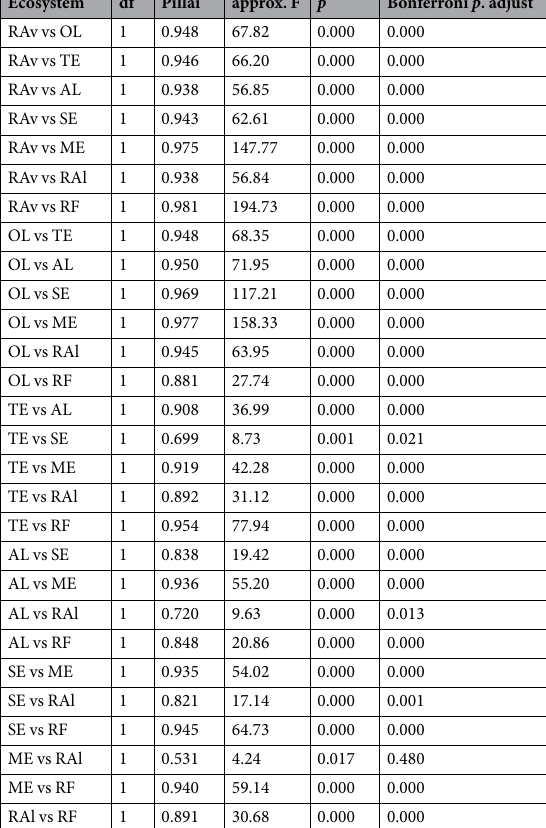
Table 1. Multivariate analysis of variance (MANOVA) of trace elements fingerprints of Cerastoderma edule shells from eight ecosystems along the Portuguese coast: Ria de Aveiro (RAv), Óbidos lagoon (OL), Tagus estuary (TE),